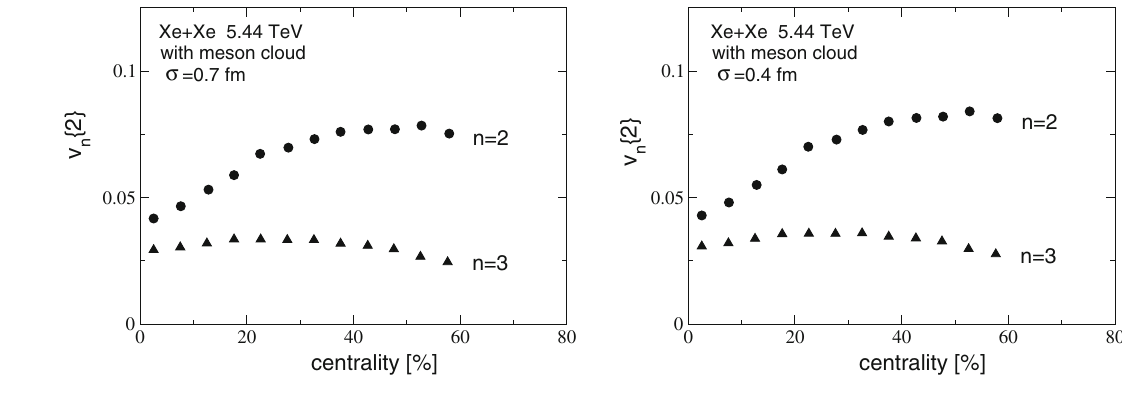
Fig. 8 Same as in Fig. 7 but for Xe + Xe collisions at